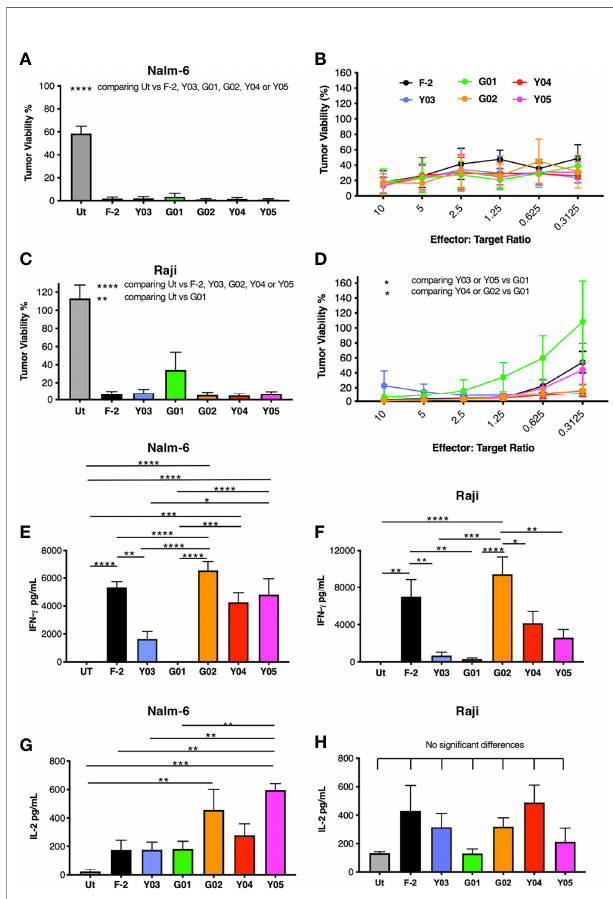
FIGURE 3 | In vitro activation of scFv mutated CD19-speci fi c CARs. (A) 2x10 4 of the indicated CAR T-cell populations were co-cultivated with NALM- 6 leukemic cells [1:1 ratio – (A) ; indicated effector to target cell ratio - (B) ] or Raji cells [1:1 ratio – (C) ; indicated effector to target cell ratio - (D) ]. After 72h, residual viability of tumor cells was determined by luciferase assay (mean ± SEM of n=3 independent replicates). Supernatants were collected 24h after co-cultivations described in (A, C) were established. These were analyzed for IFN- g [Nalm-6, (E) ; Raji, (F) ] or IL-2 [Nalm-6, (G) ; Raji, (H) ] by ELISA (mean ± SEM of n=6 independent replicates). Statistical analysis was performed by one-way ANOVA (A, C, E – H) or two-way ANOVA (B, D) followed by Tukey ’ s multiple comparison test. Ut. - untransduced T-cells. **** p < 0.0001; *** p ≤ 0.001; ** p ≤ 0.01; * p ≤ 0.05.